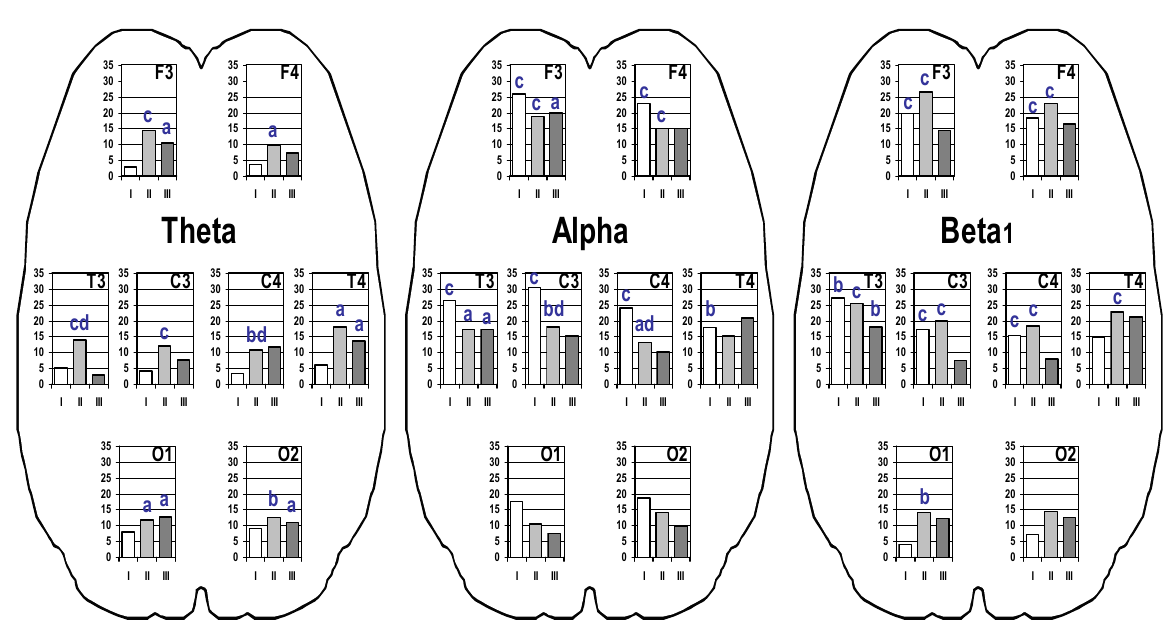
Figure 1. Percentage gains (in %) of the EEG spectral power in frequency EEG bands in the dynamics of HRV BF session in adolescents with different risks of Internet addiction (IA). F3, F4, C3, C4, T3, T4, O1, O2–left and right frontal, central, temporal and occipital EEG points. White bars, group with a minimal IA risk (I); light grey bars, group with a tendency towards IA (II); dark grey bars, group with a stable IA pattern (III). Statistically significant difference between baseline and after HRV BF session parameters: ‘a’, p < 0.05; ‘b’, p < 0.01; ‘c’, p < 0.001; ‘d’, p < 0.05 between Groups I and II after the HRV BF session.